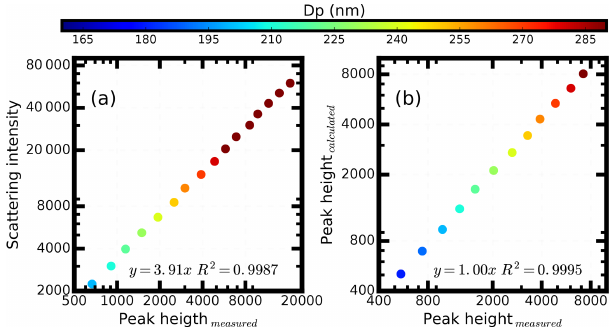
Figure 4. (a) The relationship between the scattering peak height from the SP2 high-gain scattering channel when calibrating by us- ing the ammonia sulfate, and (b) the comparison between the mea- sured scattering peak height from SP2 high-gain scattering chan- nel using the ammonia chloride and the calculated scattering peak height using the Mie scattering theory. Different colors represent the results at different diameters.